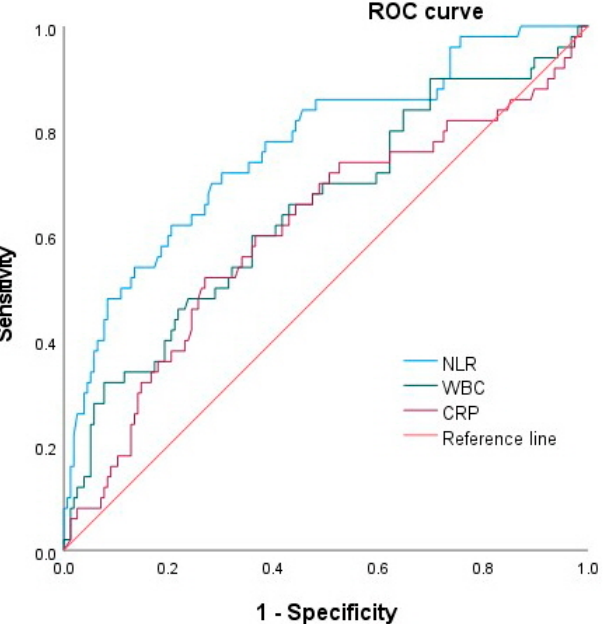
Figure 4. Receiver operating characteristic curve for NLR, WBC and CRP as predictors of positive blood culture. NLR, neutrophil–lymphocyte ratio; WBC, white blood cell; CRP, C-reactive protein. 3.4. Role of SOFA Score in Predicting Severe Acute Cholangitis, Shock, and Positive Blood Culture The ROC curves for the SOFA score as predictors of severe acute cholangitis, shock, and positive blood culture are shown in Figure 5. The AUCs for predicting severe cholangitis, shock, and positive blood culture were 0.87 (95% CI, 0.82–0.91, p < 0.001), 0.93 (95% CI, 0.88–0.96, p < 0.001) and 0.72 (95% CI, 0.65–0.78, p < 0.001), respectively. The optimal cut-off values of the SOFA score for predicting severe acute cholangitis, shock, and positive blood culture were 3 (sensitivity, 89%; specificity, 84%), 3 (sensitivity, 100%; specificity, 78.1%), and 2 (sensitivity, 82%; specificity, 52%), respectively.